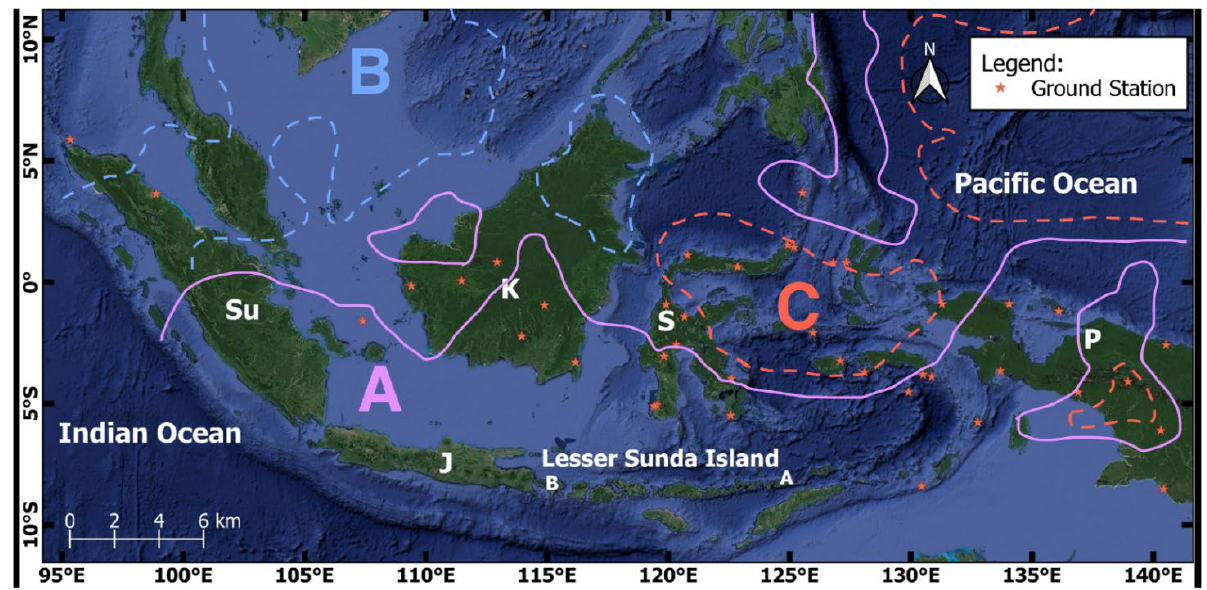
Figure 1. Map of study area. The names of islands (marked by lowercase alphabet letters) are Sumatra (Su), Kalimantan (K), Java (J), Bali (B), Alor (A), Sulawesi (S), and Papua (P). The star sign indicates the available meteorological stations. The uppercase alphabet letters of A (purple color), B (blue color), and C (red color) shows the three regions used in this research “Reprinted/adapted with permission from Ref. [45]. 2017, Balai Besar Teknologi Modifikasi Cuaca”. The purple line means the borderline of Region A, the blue dash line means the borderline of Region B, and the red dash line means the borderline of Region C.